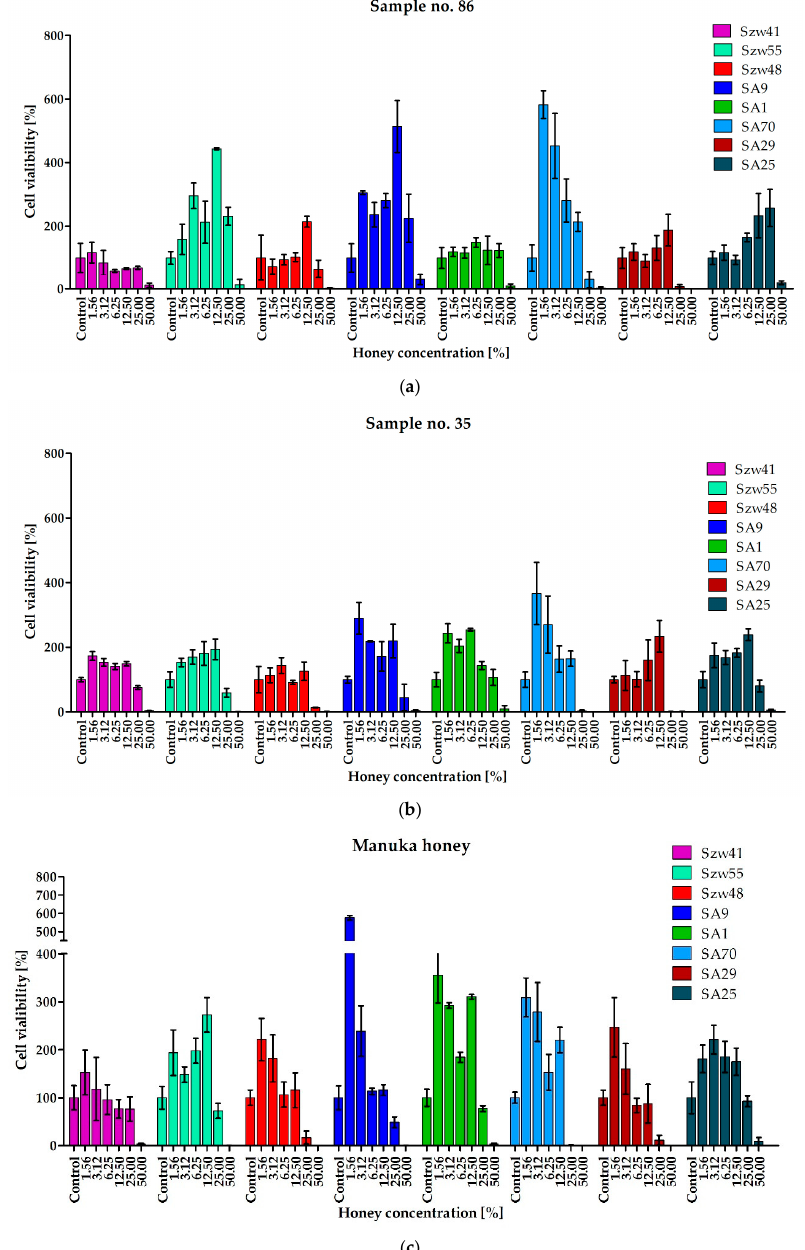
Figure 2. Anti-biofilm activity of selected honeys: ( a ) 86; ( b ) 35; ( c ) manuka.